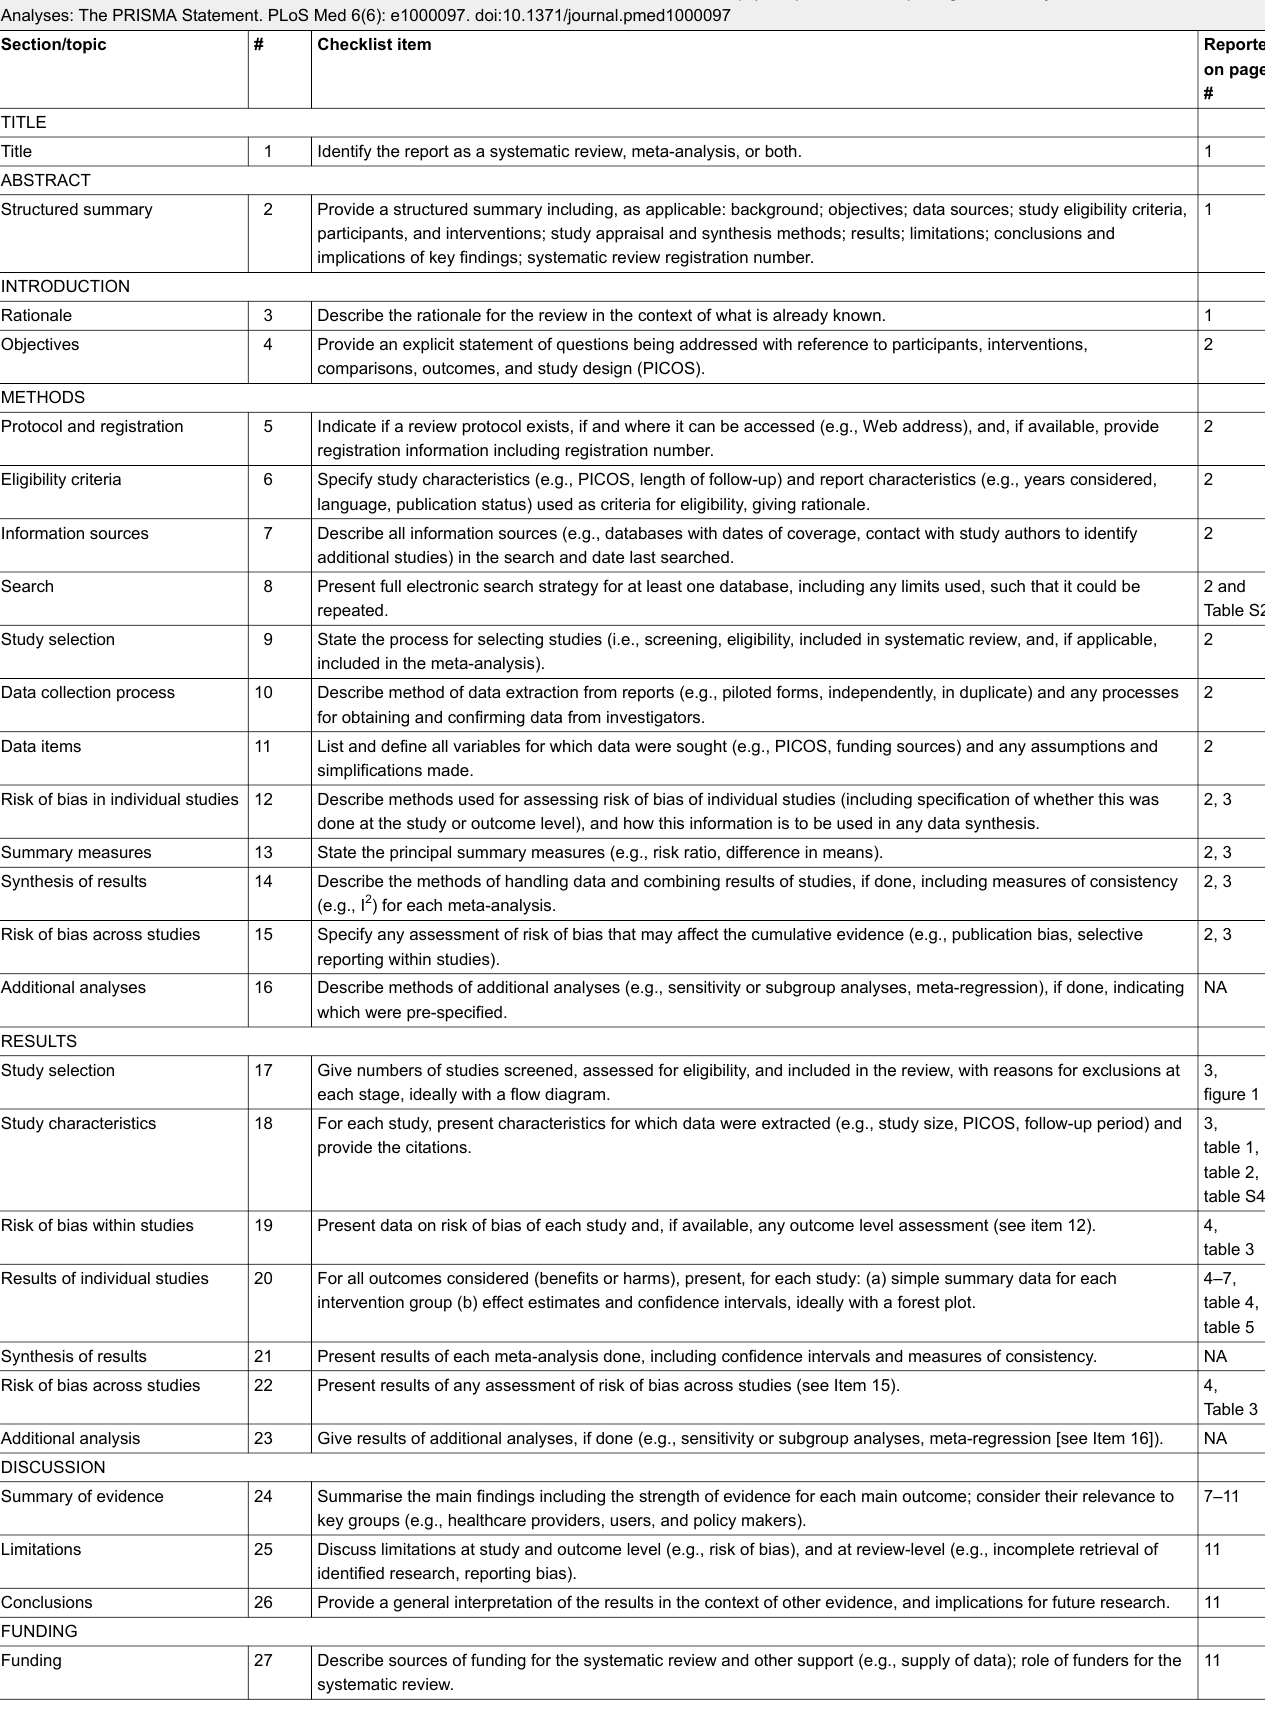
Table S1: PRISMA Checklist. From: Moher D, Liberati A, Tetzlaff J, Altman DG, The PRISMA Group (2009). Preferred Reporting Items for Systematic Reviews and Meta- Analyses: The PRISMA Statement. PLoS Med 6(6): e1000097. doi:10.1371/journal.pmed1000097 Section/topic # Checklist